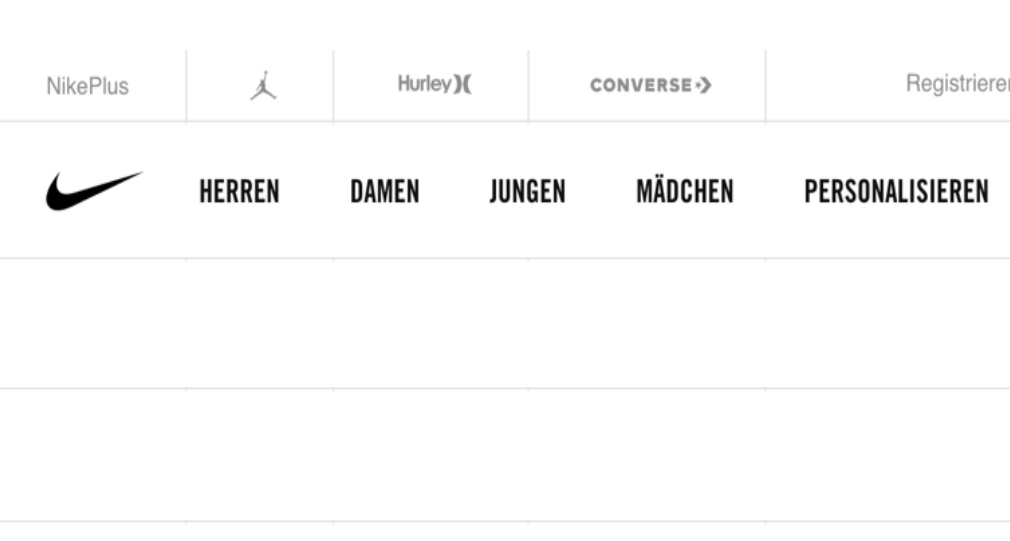
Figure 2 (top): The nike website‘s navigation bar is gender based even for children. Source: http://nike.com/de/de_de. Accessed: November 19, 2017.